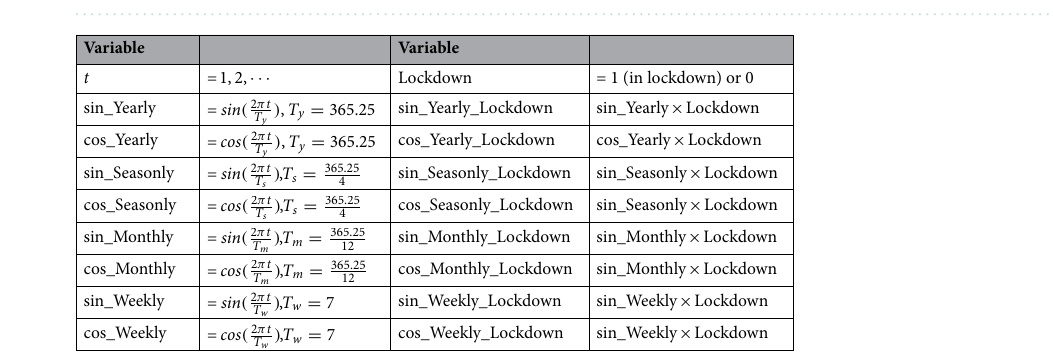
Figure 2. The overall of the proposed AQI forecasting framework.